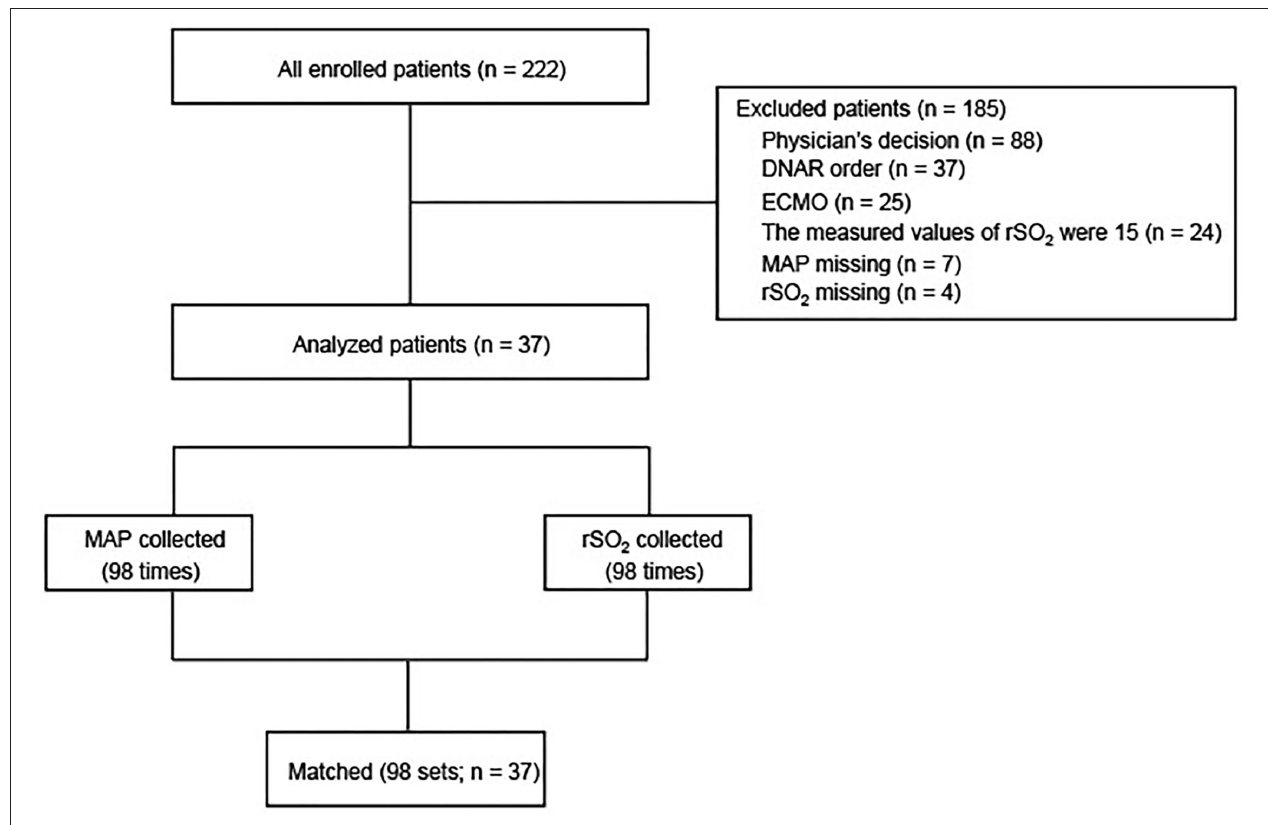
FIGURE 1 | Flowchart of screening and enrollment of patients in this study. DNAR, do not attempt resuscitation; ECMO, extracorporeal membrane oxygenation; MAP, mean arterial pressure; rSO 2 , regional saturation of oxygen; SAP, systolic arterial